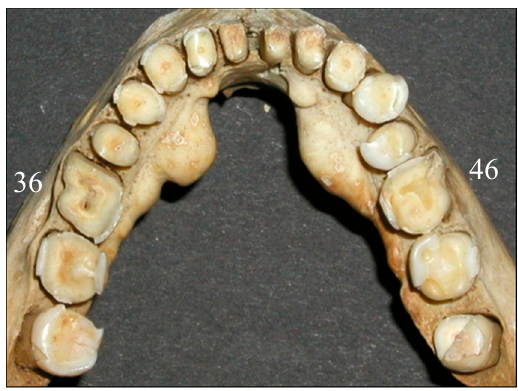
Figure 4. Secondary dentin formation seen in tooth 46, while tooth 36 has excessive wear with pulp exposure.